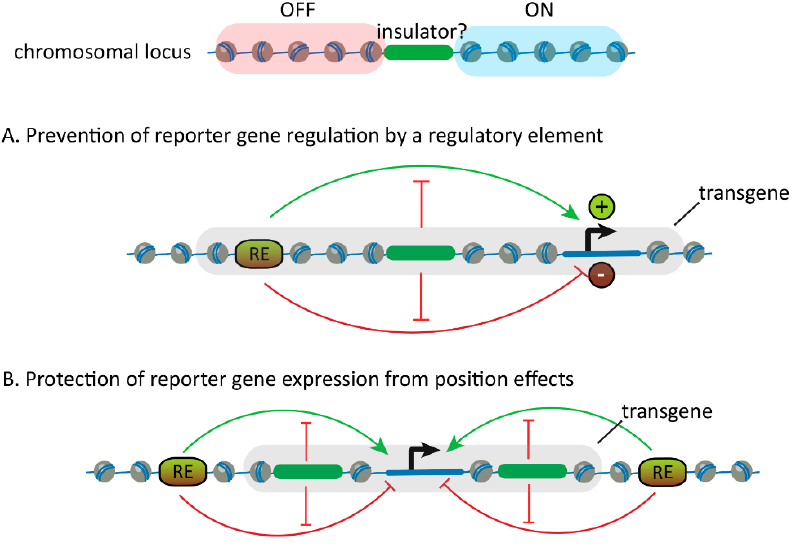
Figure 1. Insulator reporter assays. (Top) Candidate insulators (green) have been selected based on their locations between chromosomal loci (depicted as a string of nucleosomes) with di ff erent transcriptional states and tested in insulator reporter assays. ( A ) In one assay, the candidate insulator is placed between a regulatory element (RE) and a reporter gene in a transgene (grey). If it is an insulator, the reporter gene will not be regulated (activated or silenced) by the regulatory element. ( B ) In another assay, a transgene (grey) containing a reporter gene (black arrow) is flanked by candidate insulators (green) and inserted in random positions in the genome. If the candidate sequences are insulators, the reporter gene will be expressed at similar levels in di ff erent locations because it will be shielded from the influences of local regulatory elements (referred to as position e ff